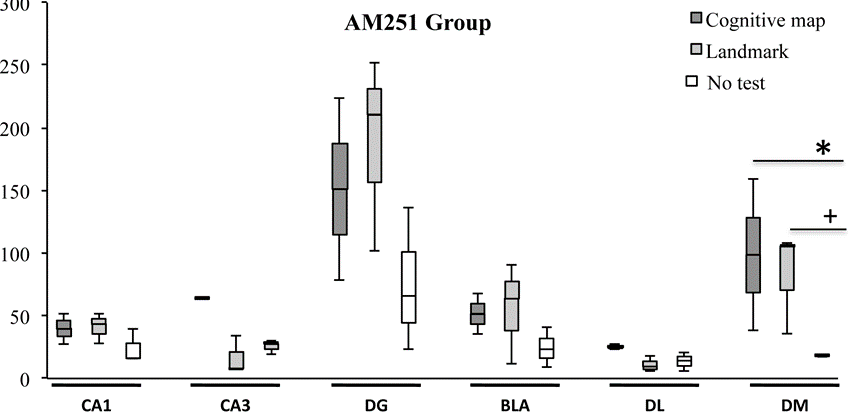
Figure 6. c-Fos activation in hippocampal CA1, CA3 and dentate gyrus (DG), basolateral amygdala (BLA) and dorsolateral (DL) and dorsomedial (DM) striatum exhibited by animals injected with AM251